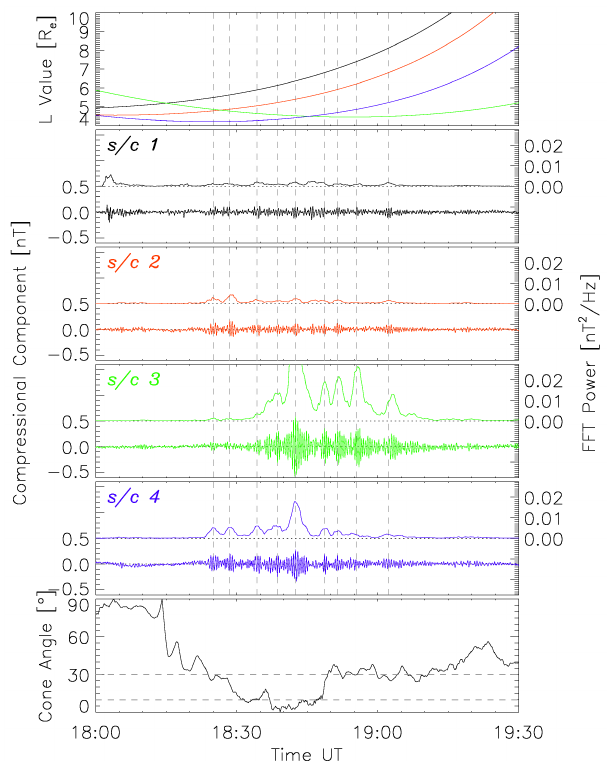
Fig. 9. Wave power in the compressional magnetic component be- tween 20 and 80mHz observed by the Cluster satellites (panels la- beled s/c 1 to s/c 4) on 5 September 2002. The right y axes give the magnitude of the integrated power. The filtered time series of the compressional magnetic field component is shown relative to the y axes on the left. The top panel shows the spacecraft’s L value. The bottom panel shows the IMF cone